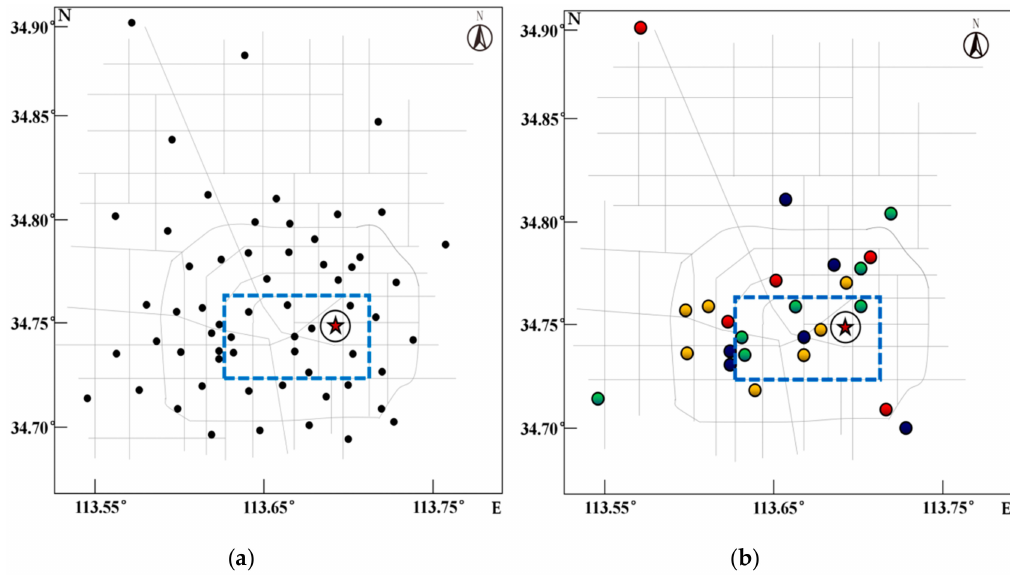
Figure 4. Zhengzhou city all tourist sites or tourist attractions geographic distribution, and the selected typical tourist sites for the experiment. ( a ) All the tourist sites or tourist attractions which are noted as black dots. The red star represents the temporary accommodation confirmed by tourists, that is the clustering center K . The blue area is the main downtown area of Zhengzhou city, the black circle represents the clustering center’s neighbourhood bu ff er to search and mine optimal tourist sites. The gray lines are the main roads and avenues of Zhengzhou city. ( b ) The four tourist site classifications with 25 typical tourist sites. Green represents the park and greenland classifications, blue represents the venue classification, red represents the amusement classification, and yellow represents the shopping center